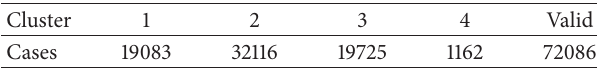
Table 5: Number of cases in each of the clusters (surgical patients).